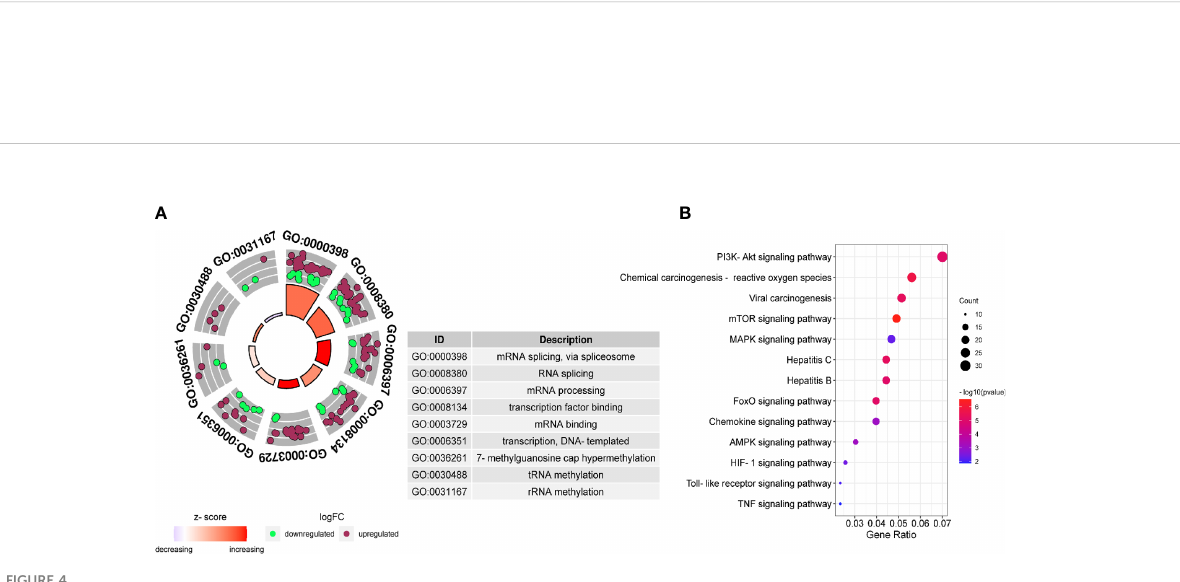
FIGURE 4 Gene Ontology (GO) and Kyoto Encyclopedia of Genes and Genomes (KEGG) pathway of DEGs. GO (A) and KEGG (B) enrichment analysis were performed on the key module